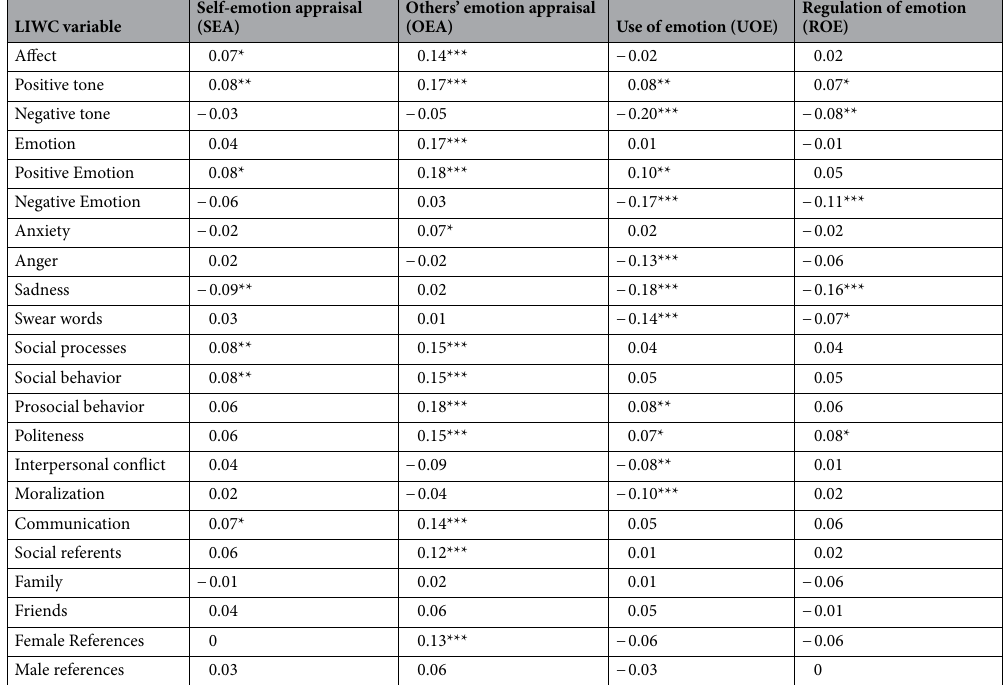
Table 3. Correlations of text variables for each of the four dimensions of EI. Only variables which exhibit correlations that are significant to the 5% percent level (p-values ≤ 0.05) are listed. Correlations between social- and affect-related text variables and emotional intelligence. *p ≤ 0.10, **p ≤ 0.05, ***p ≤